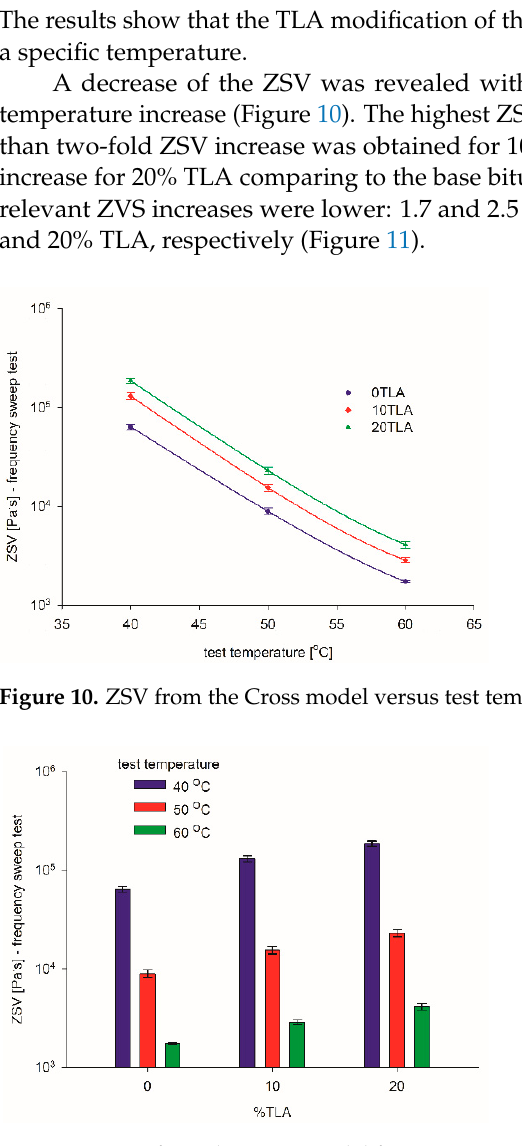
Figure 11. ZSV from the Cross model for various TLA content and test temperatures.